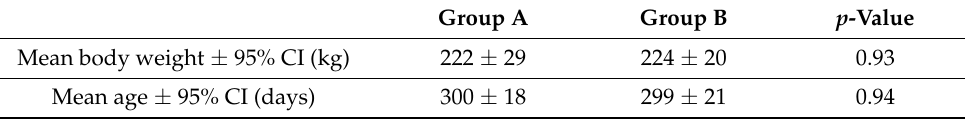
Figure 1. Experimental device of the two cattle groups (( a ) general view) and pedometers installed on the tail of cattle (( b ) detail; ( c ) group). Table 1. Mean age and weight of the animals of Group A and B and p -values of t -test. Group